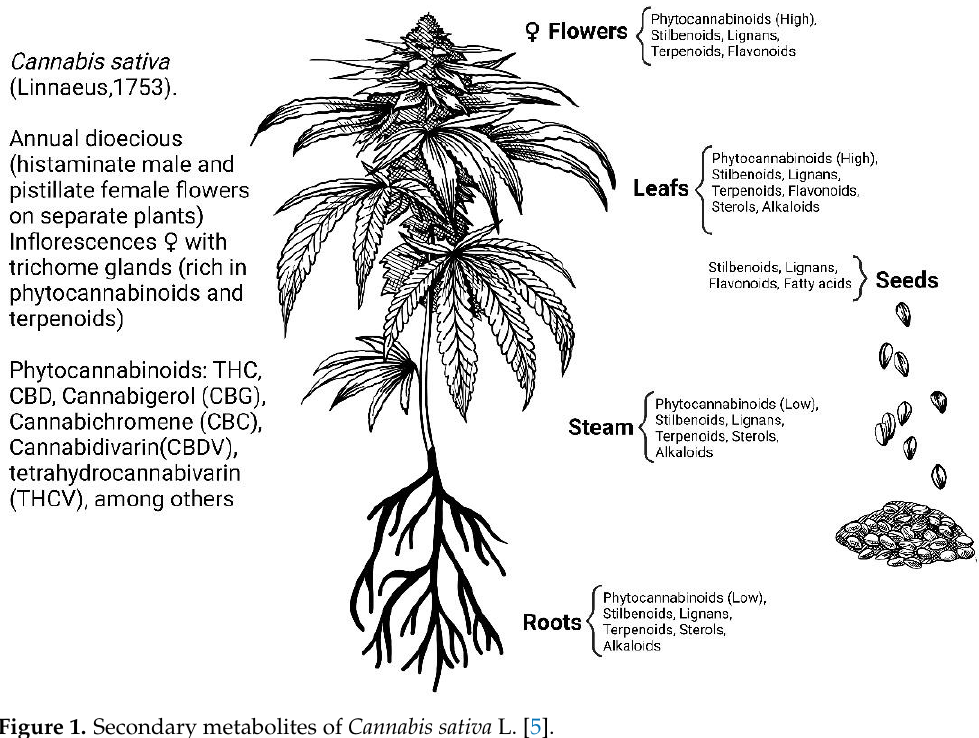
Figure 1. Secondary metabolites of Cannabis sativa L. [5].